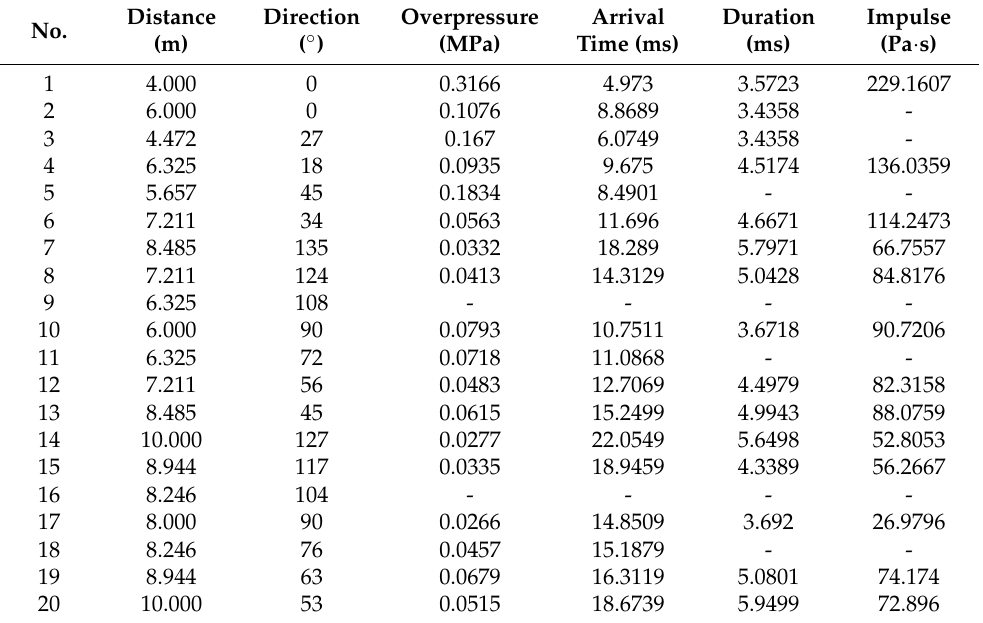
Table A3. Shock wave parameters of a moving charge explosion experiment ( V = 580 m/s, x = +2